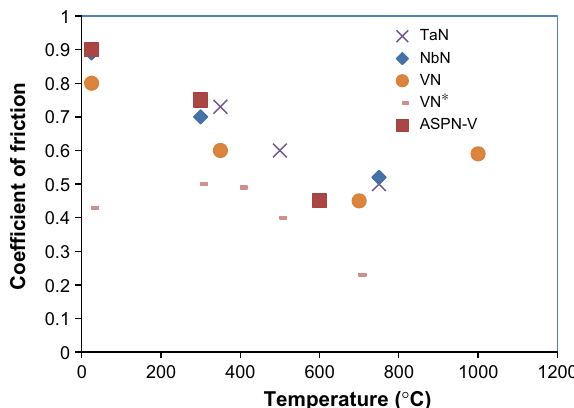
Figure 1. Recorded friction coefficient of a few of nitrides at different temperatures: NbN [24], TaN [25], VN* [18]/VN [26] and our research of